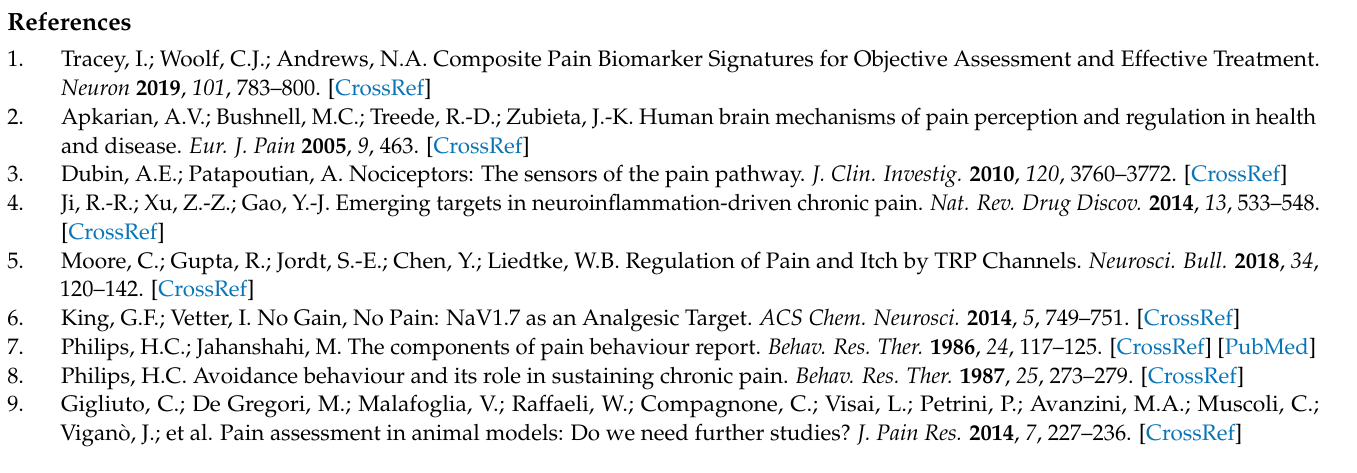
Table S5. Branch detected positive selection for pain-related genes by the branch model; Table S6. Branch detected positive selection for pain-related genes by the branch site model; Table S7. Predicted deleterious score by PROVEAN and PolyPhen2; Figure S1. Identification of ASIC4 gene of L.vexillifer and N. asiaeorientalis . The purplish red box indicates the stop